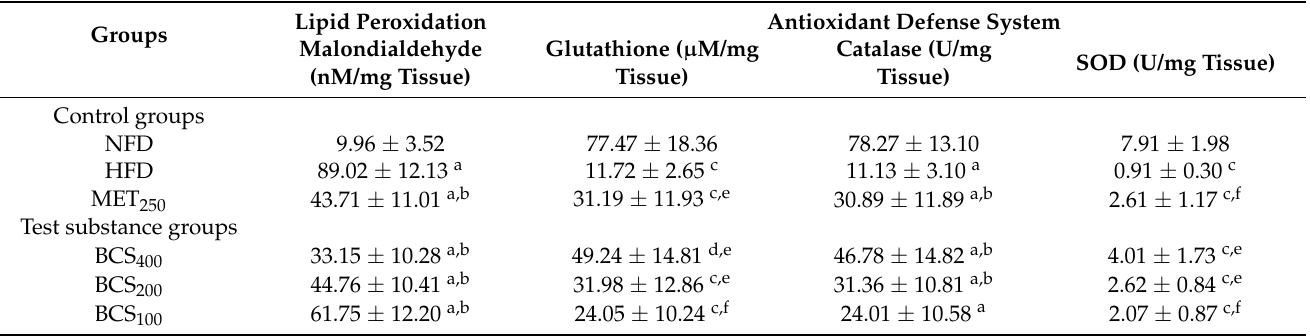
Table 8. Antioxidant defense systems and liver lipid peroxidation in HFD- and NFD-supplied groups. Lipid Peroxidation Antioxidant Defense Groups